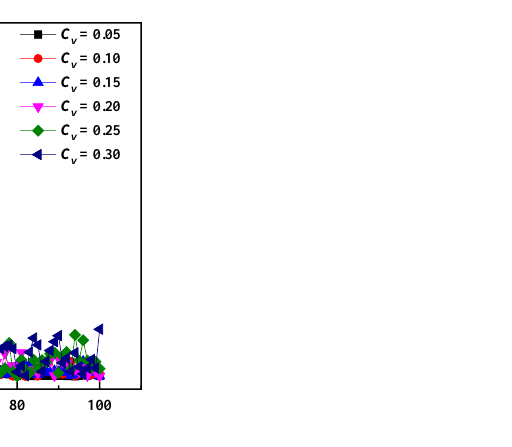
Figure 26. Center concentration deviation under different relative standard deviations of velocity at velocity 1.35 m/s.